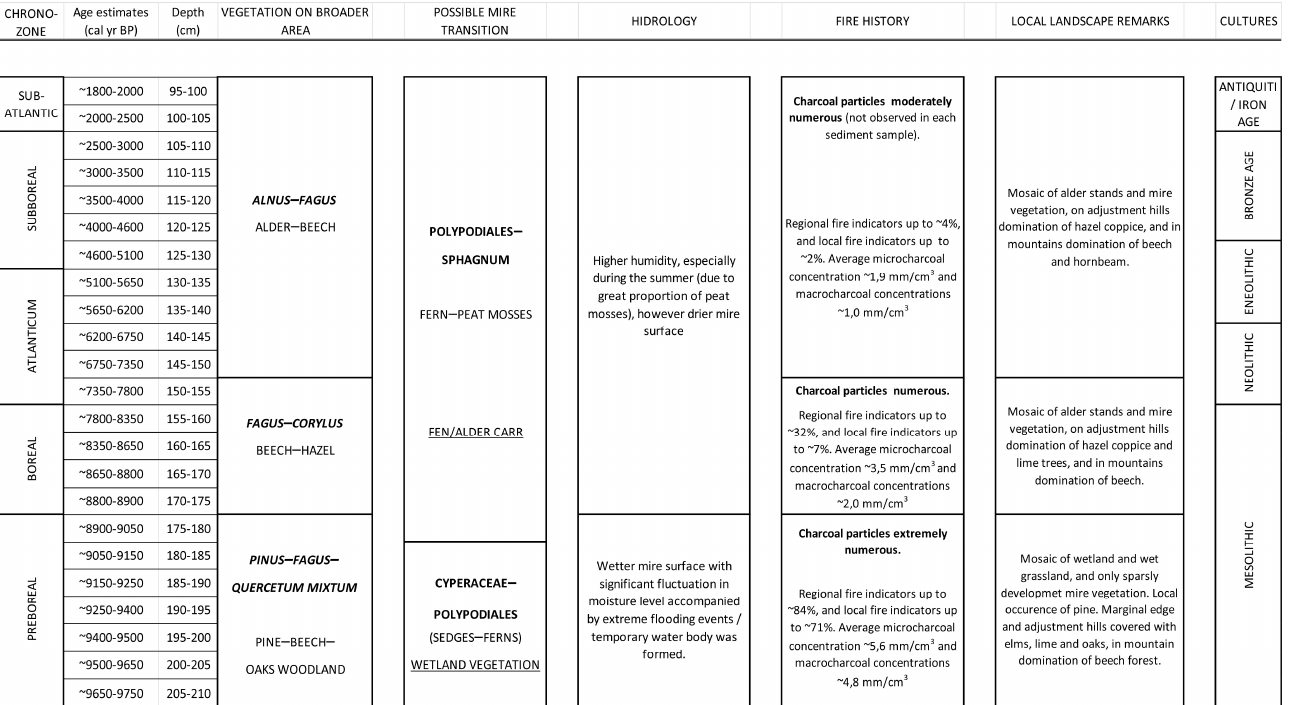
Figure 5. Palaeoenvironmental reconstruction (summarized description) of the Blatuša mire based on different proxies. Chronozones are based mainly on Frey and Lösch [129], and the culture timeline on Ložnjak Dizdar and Potrebica [78] and Težak-Gregl [74].